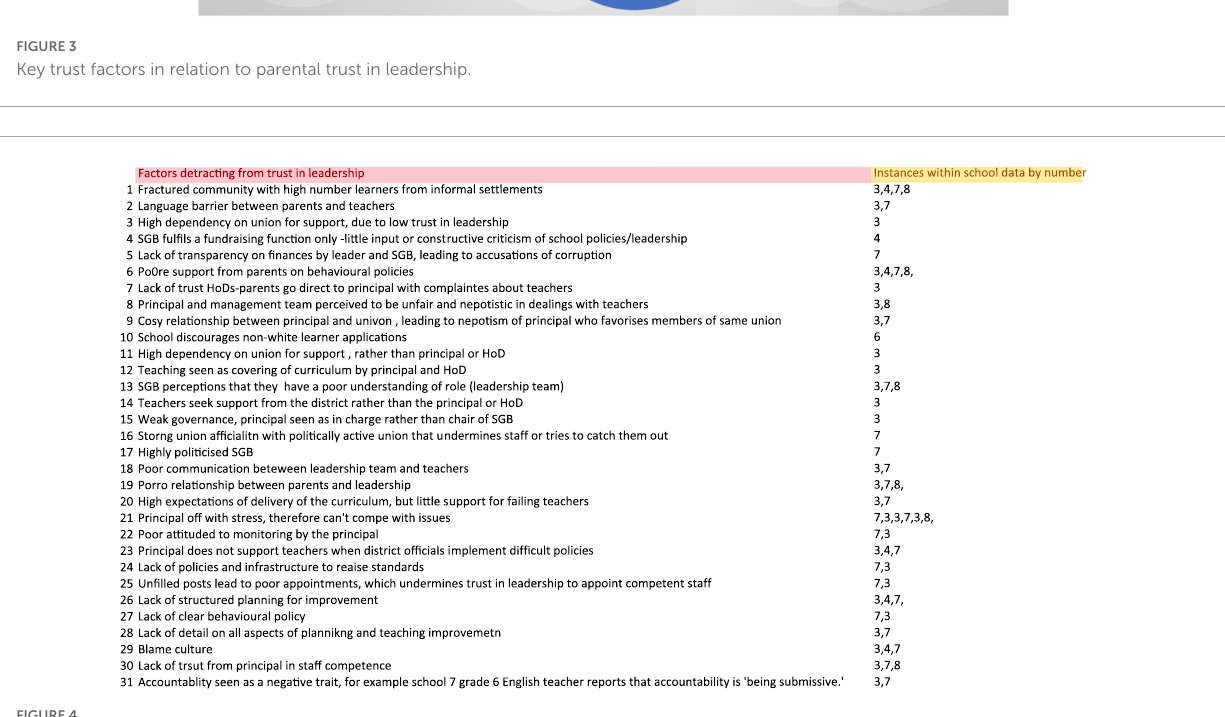
FIGURE4 Factors detracting from trust in